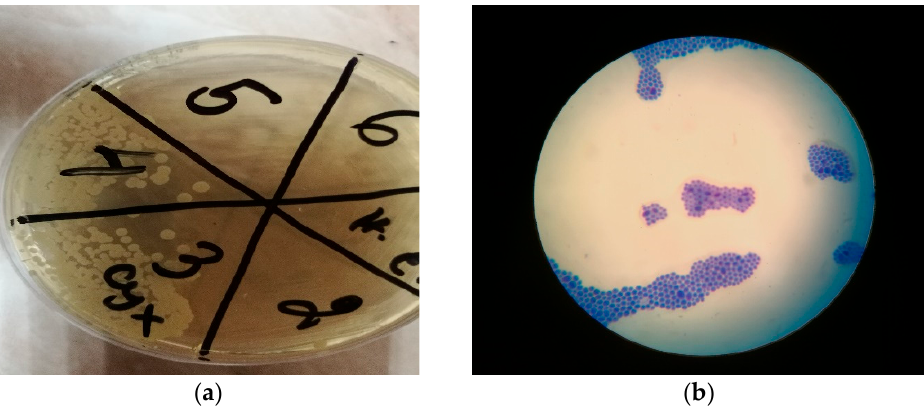
Figure 10. ( a ) SDA agar. Fungal growth on 3 (sample taken from the palate) and 4 (sample taken from the denture). No fungal growth observed on the negative control (n. c.). 2—sample from the vibrating line area, 5—sample from tuber maxillae sin., 6—sample from tuber maxillae dex. ( b ) Fungi, methylene blue stain, ×100 immersion oil microscopy.